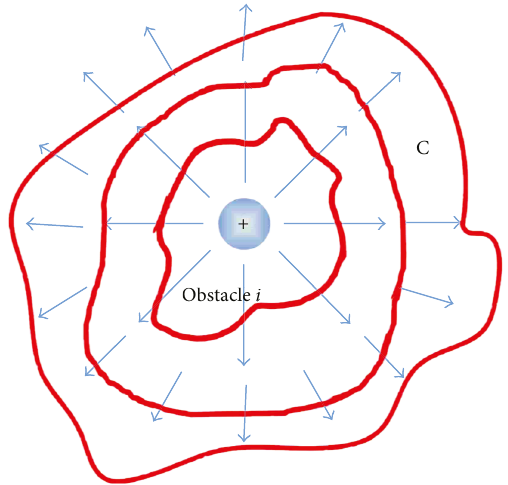
Figure 5: The fl ux of the force fi eld is conserved for any